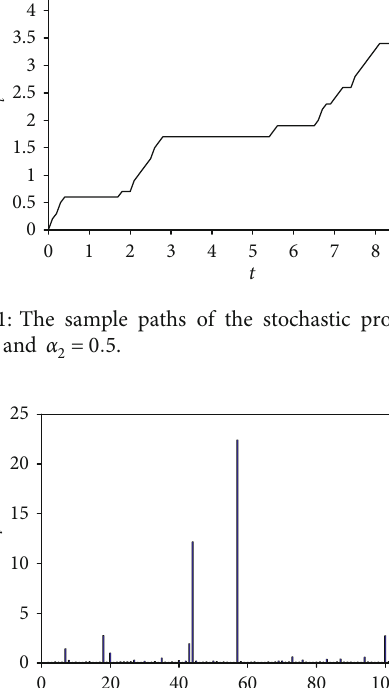
Figure 2: The corresponding waiting times with α 0 : 5